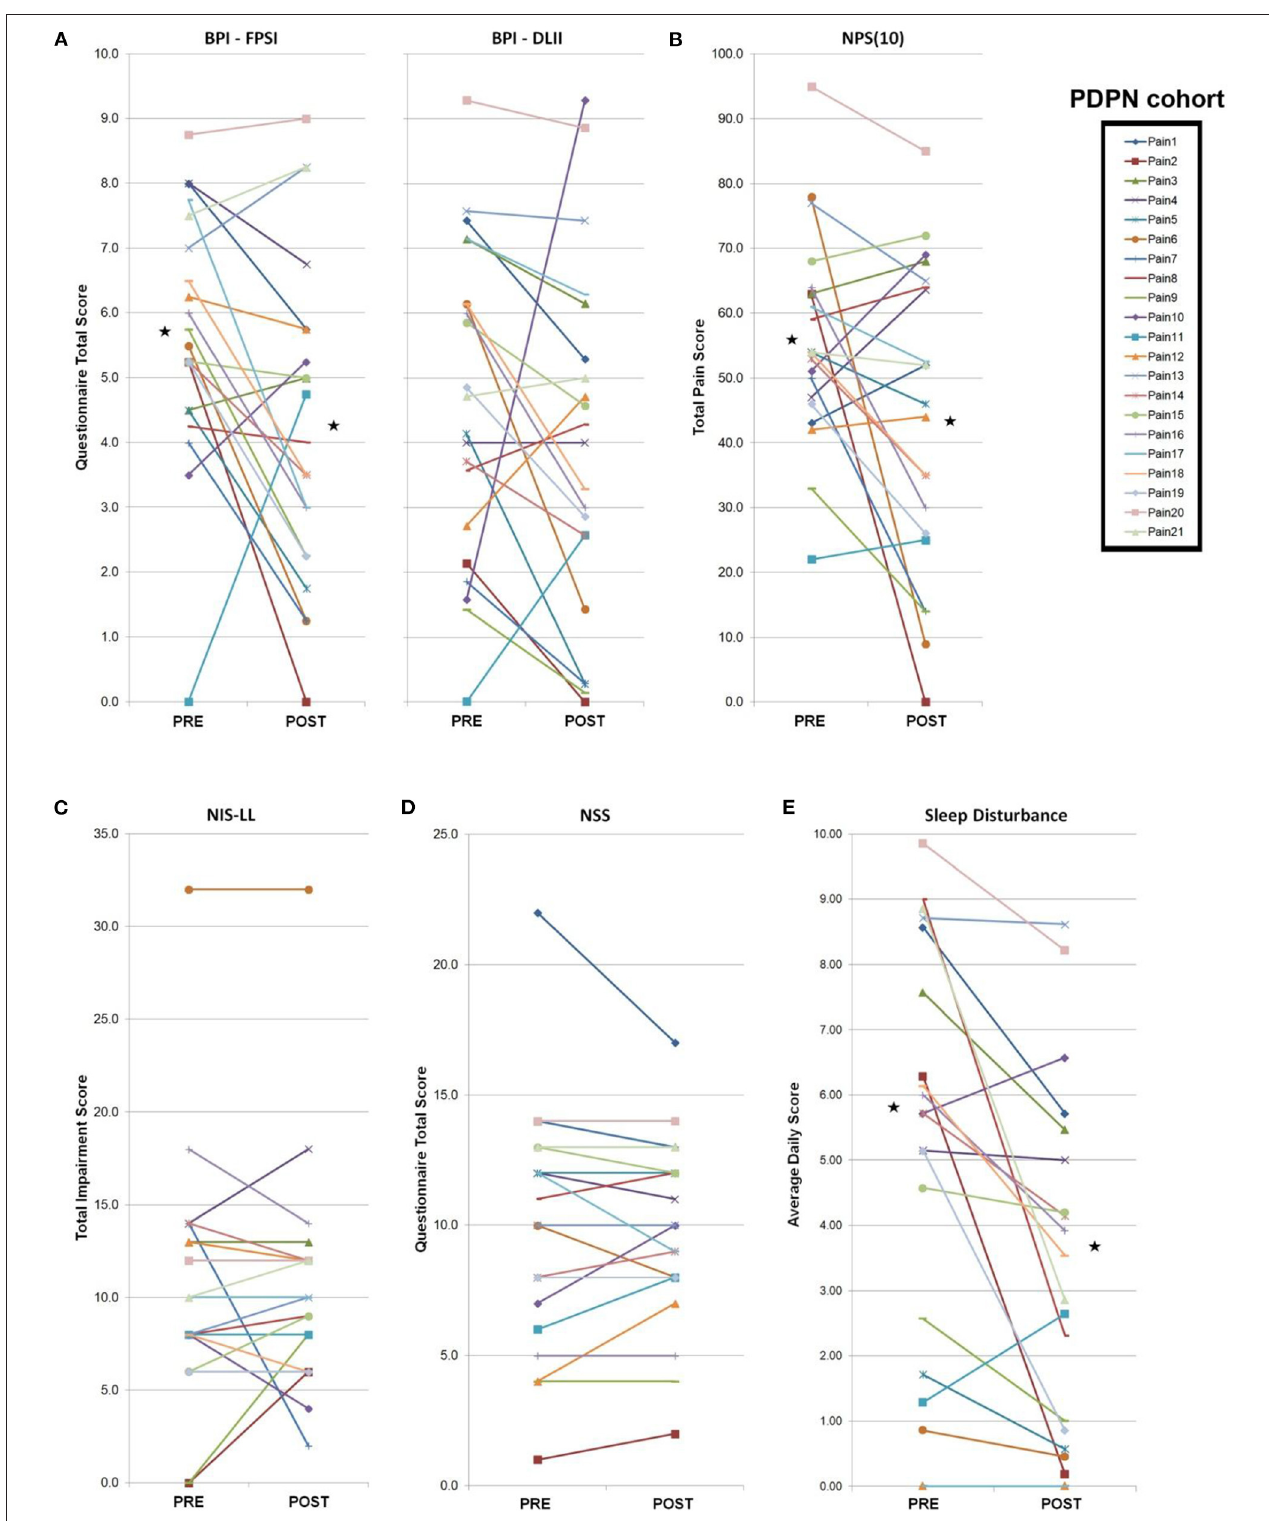
FIGURE 2 | PDPN cohort individual clinical measures. Total PDPN cohort ( n = 21) individual clinical symptoms responses (questionnaires, measures, composite sleep disturbance). Black stars represent the group average values with significant differences ( p < 0.05 by paired Student’s t -test). (A) Following a 4-week topical 5% lidocaine treatment, significant improvements were observed on the BPI-FPSI, but not the BPI-DLII. (B) Significant improvements were observed on the NPS (10) score. (C) No significant group changes were observed for the NIS-LL score, or (D) the NSS score. (E) Significant improvements were observed in group composite sleep disturbance